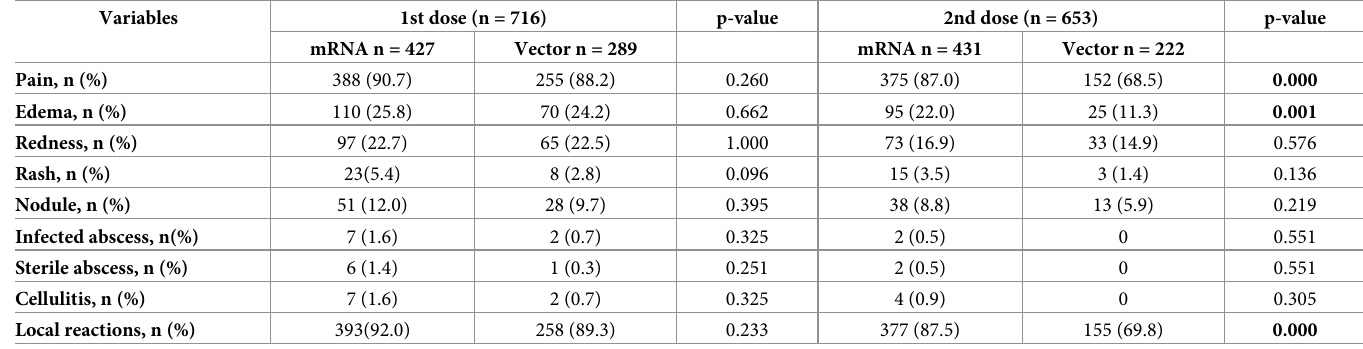
Table 2. Local reactions after first and second dose with mRNA and vector